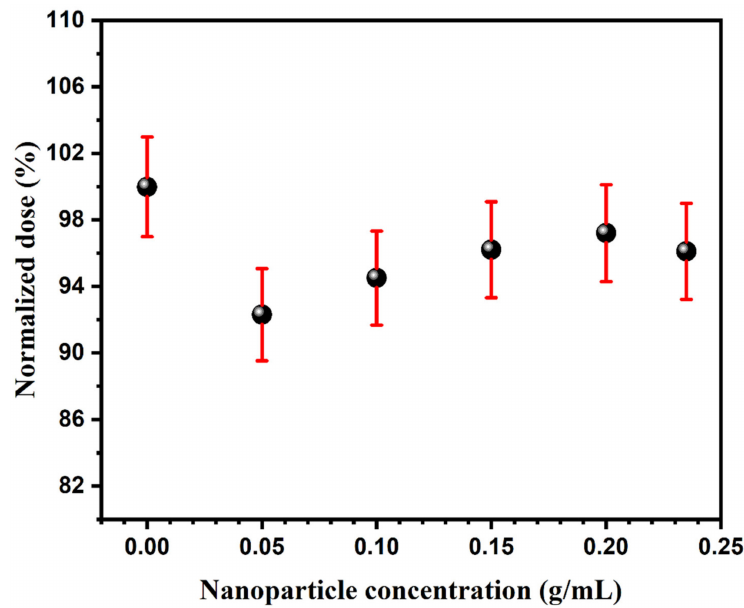
Figure 6. Normalized surface dose as a function of nanoparticle concentration recorded for the 125 kVp radiation beams.